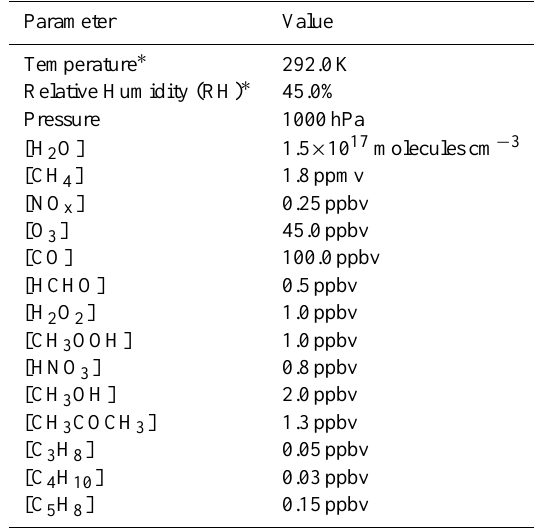
Table 1. Initial chemical and physical conditions for the box model